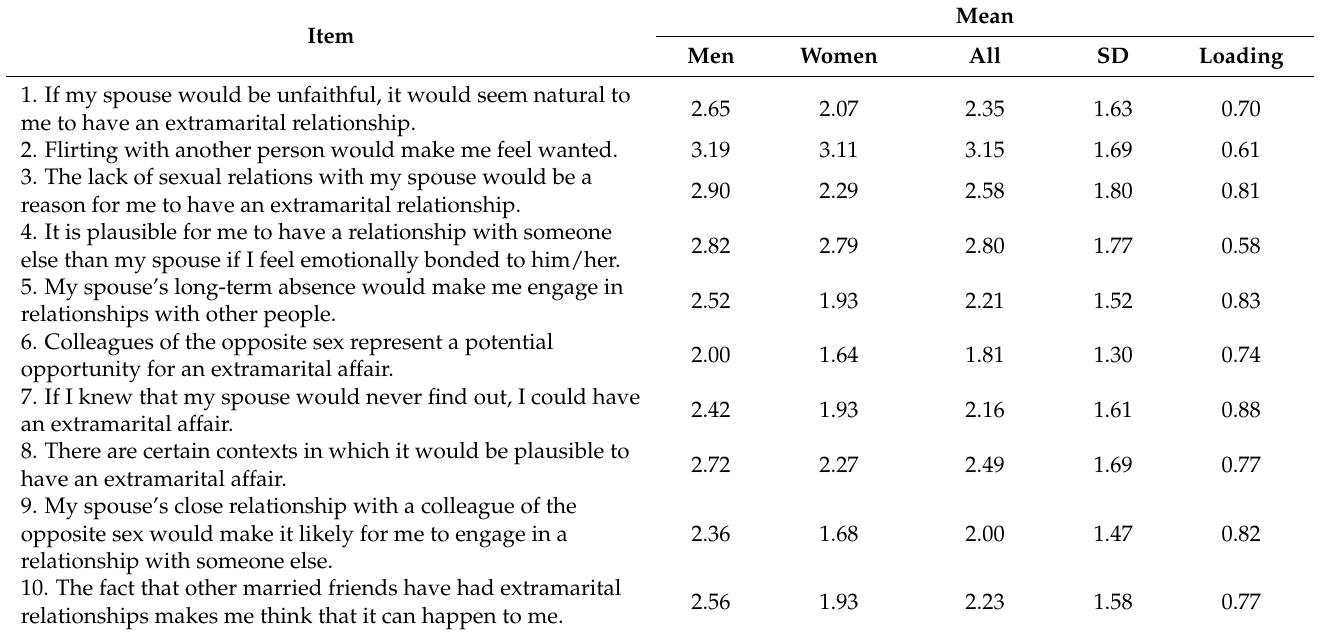
Table 2. The items of the Propensity Towards Infidelity Scale, with means, standard deviations, and final factor loadings (Study 2).